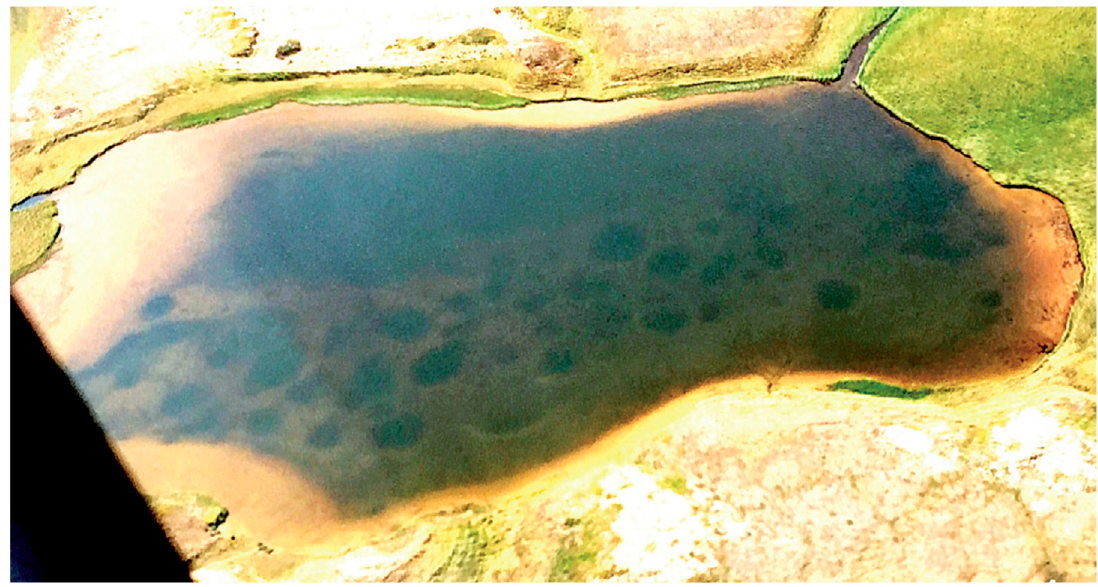
Figure 4. “Permafrost pockmarks” on Yamal thermokarst lake bottom (photo by V.I. Bogoyavlensky from helicopter).